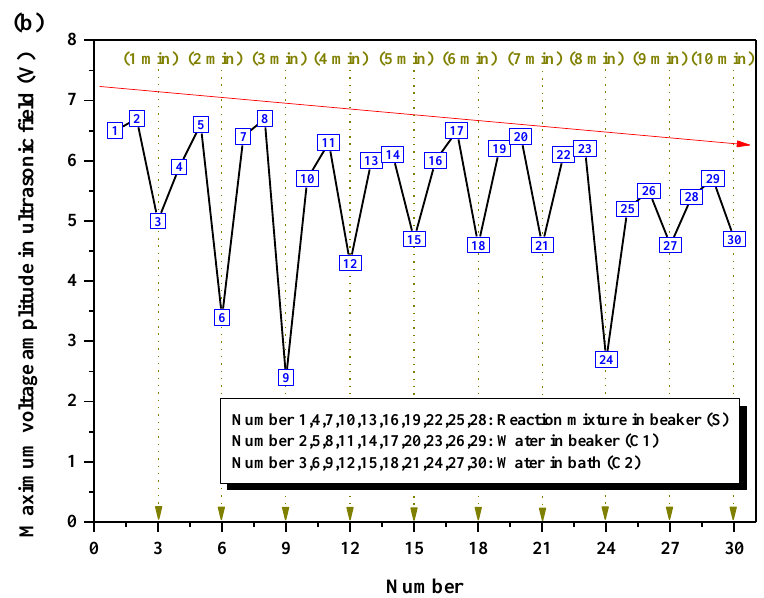
Figure 7. Maximum voltage amplitude during ultrasound-assisted synthesis of nano-ZnO at the collapse stage. ( a ) Respective difference of S , C1 , and C2 ; ( b ) analysis of S , C1 , and C2 together. The maximum voltage amplitudes in S , C1 , and C2 are compared and analyzed to- gether during the whole ultrasound-assisted synthesis process of nano-ZnO (Figure 7b), and the regularity among them can be obtained. The maximum voltage amplitude in S is higher than that in C2 at one minute during the synthesis process. The research considers